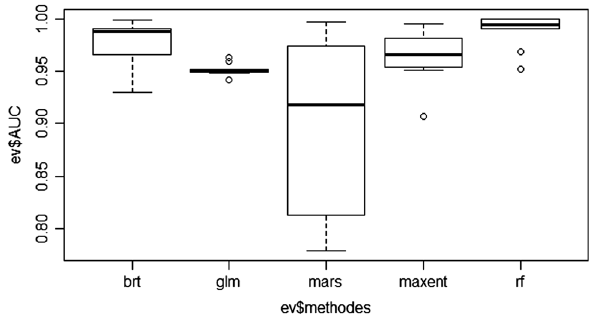
Fig. 3 area under the curve (AUC) with respect to the eight modelling techniques and the five consensus methods. Rating of the model accuracy: excellent = AUC > 0.9